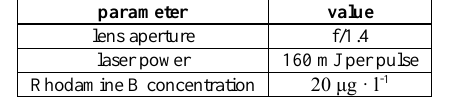
Table 2. Final parameters for the natural convection